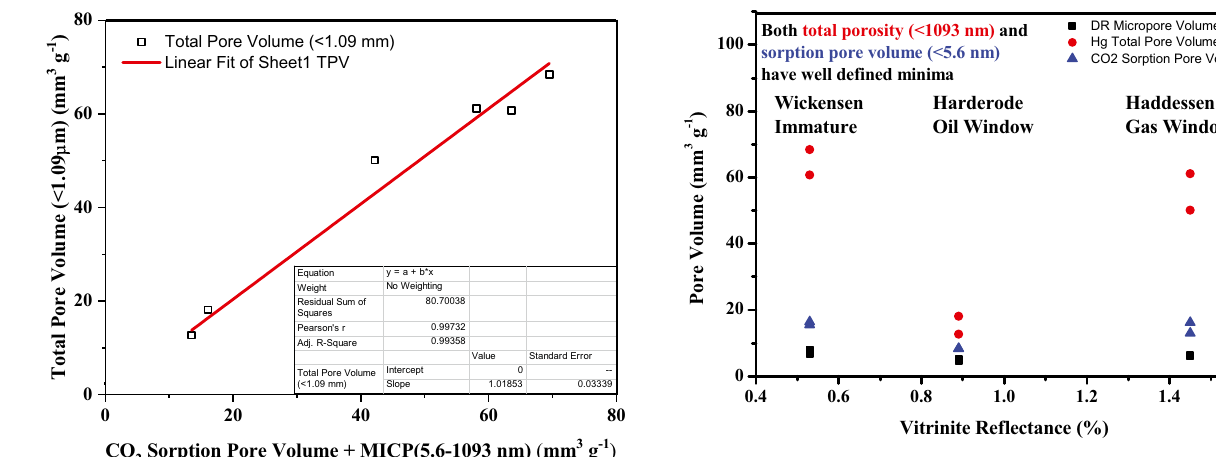
Fig. 10 The variation of shale total pore volume with the sum of CO sorption pore volume and MICP pore volume [34] 2